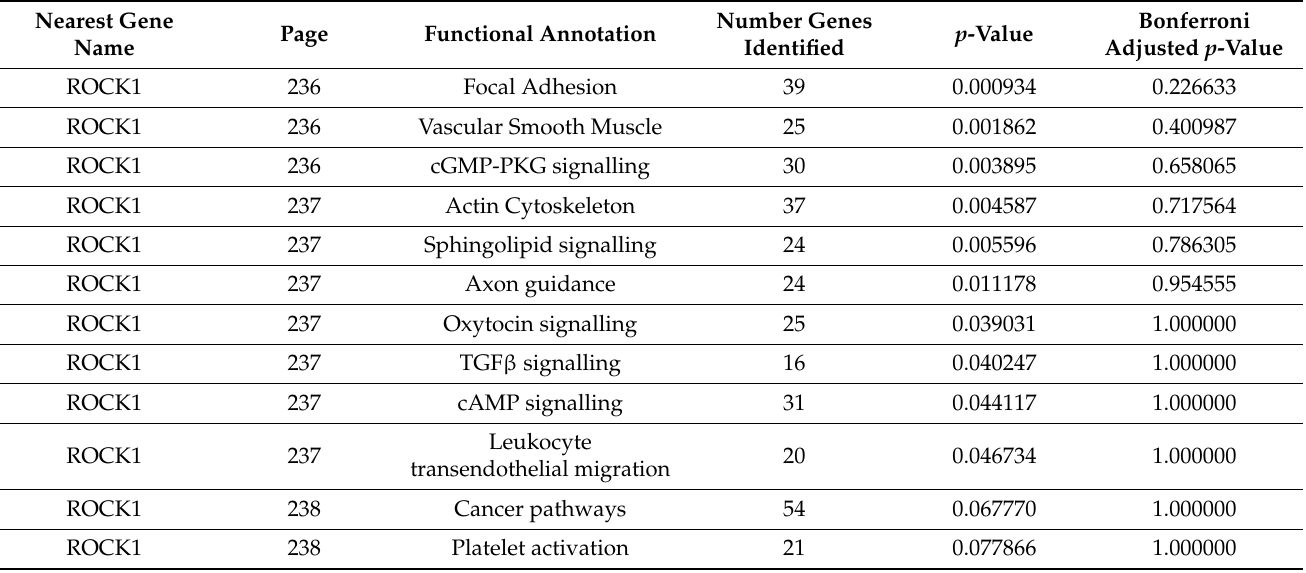
Table 21 lists some of the Schrott EWAS hits for ROCK1. Table 21. EWAS Hits from Schrott Dataset for Significantly Differentially Methylated Regions for. Major Genes of Nephrogenesis